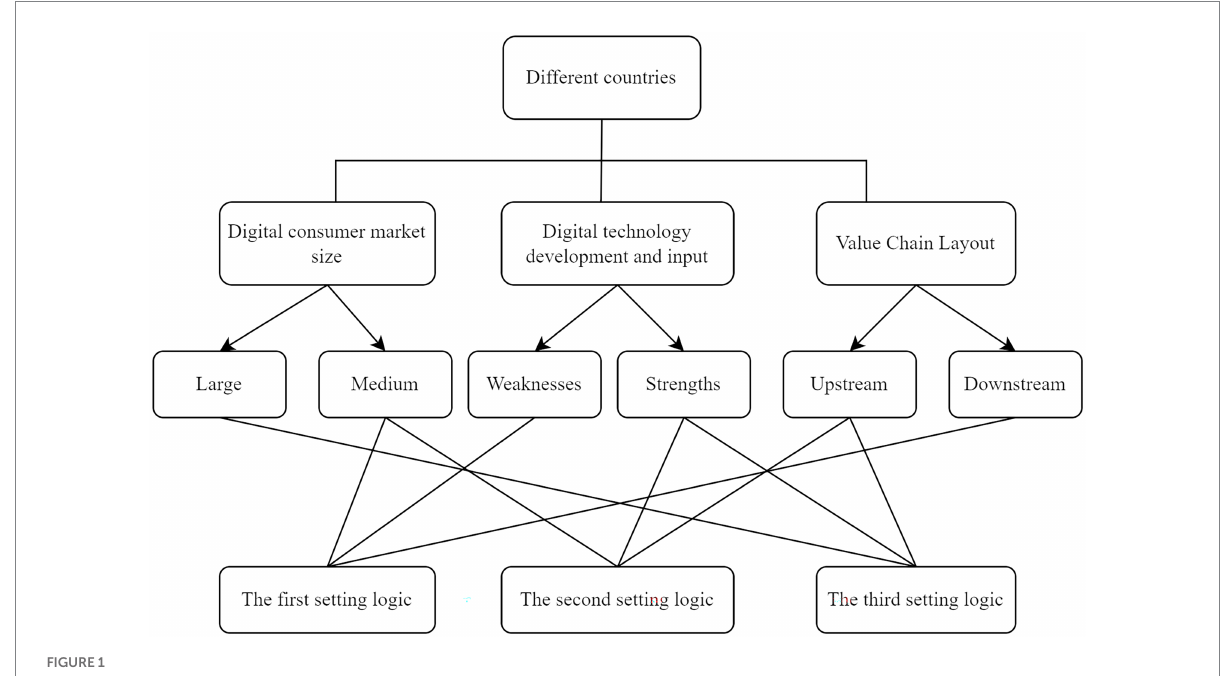
FIGURE 1 Three logics of unilateral digital service tax